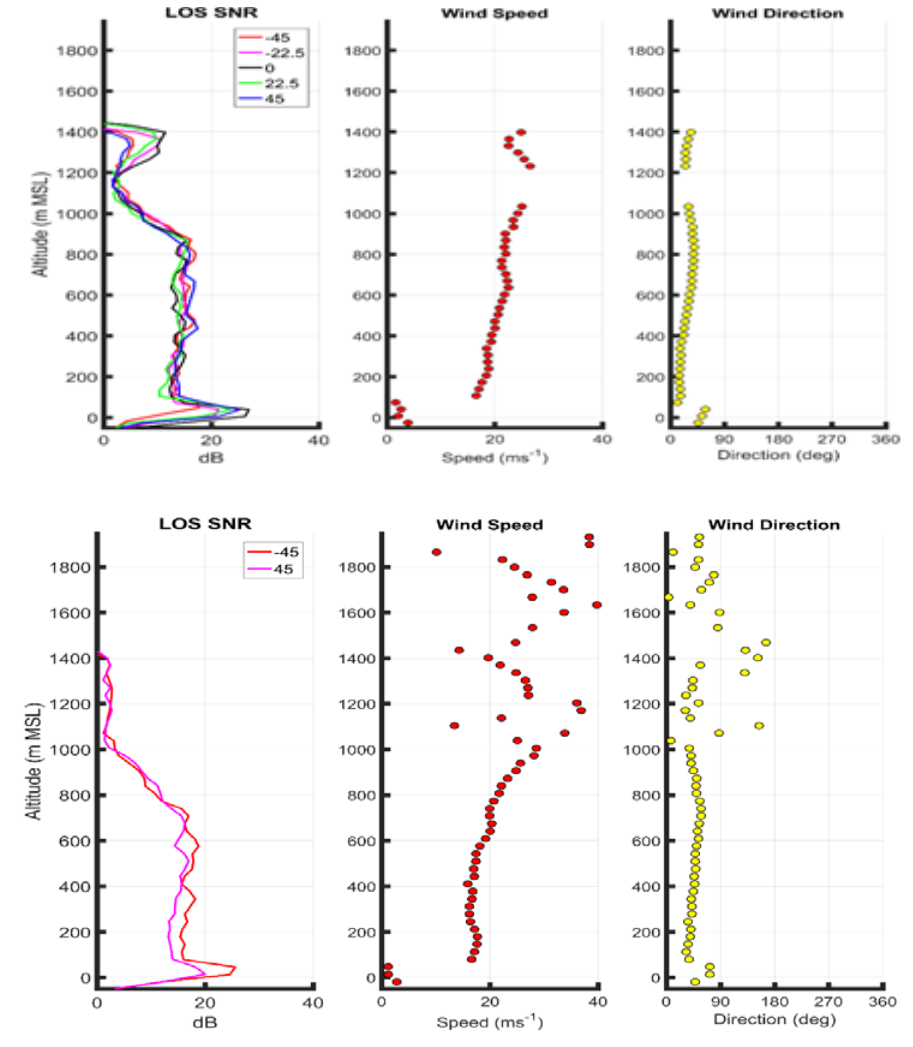
Figure 15. DAWN vertical profiles of LOS SNR, wind speed and wind direction east of the tip in leg 3 ( top ) and south of the tip in leg 6 ( bottom ) on 31 October 2014 around 1530Z.